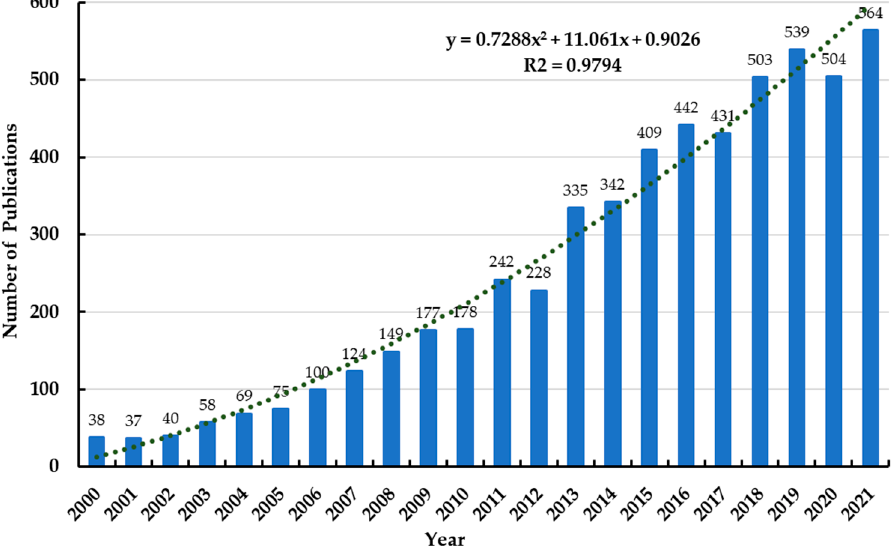
Figure 3. Number of Articles Published by NPAs Stakeholders from 2000 to 2021.